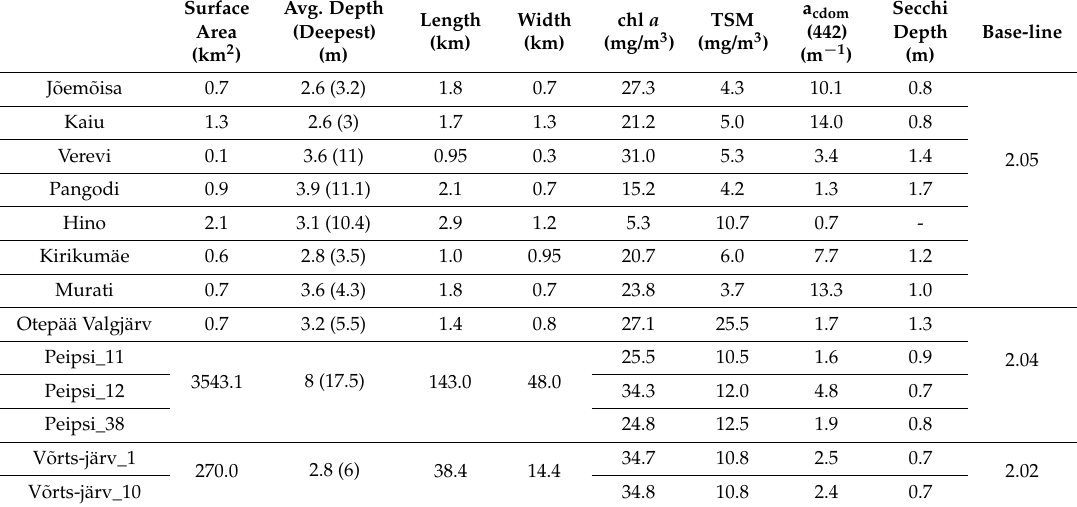
Table 3. Description of analyzed Estonian lakes, which were used for validating AC processors. Concentrations of optically active substances (OAS) in each lake were measured in the laboratory from the water samples collected during the radiometric measurements, and the processing baseline of S2 MultiSpectral Instrument (MSI) images is added in the last